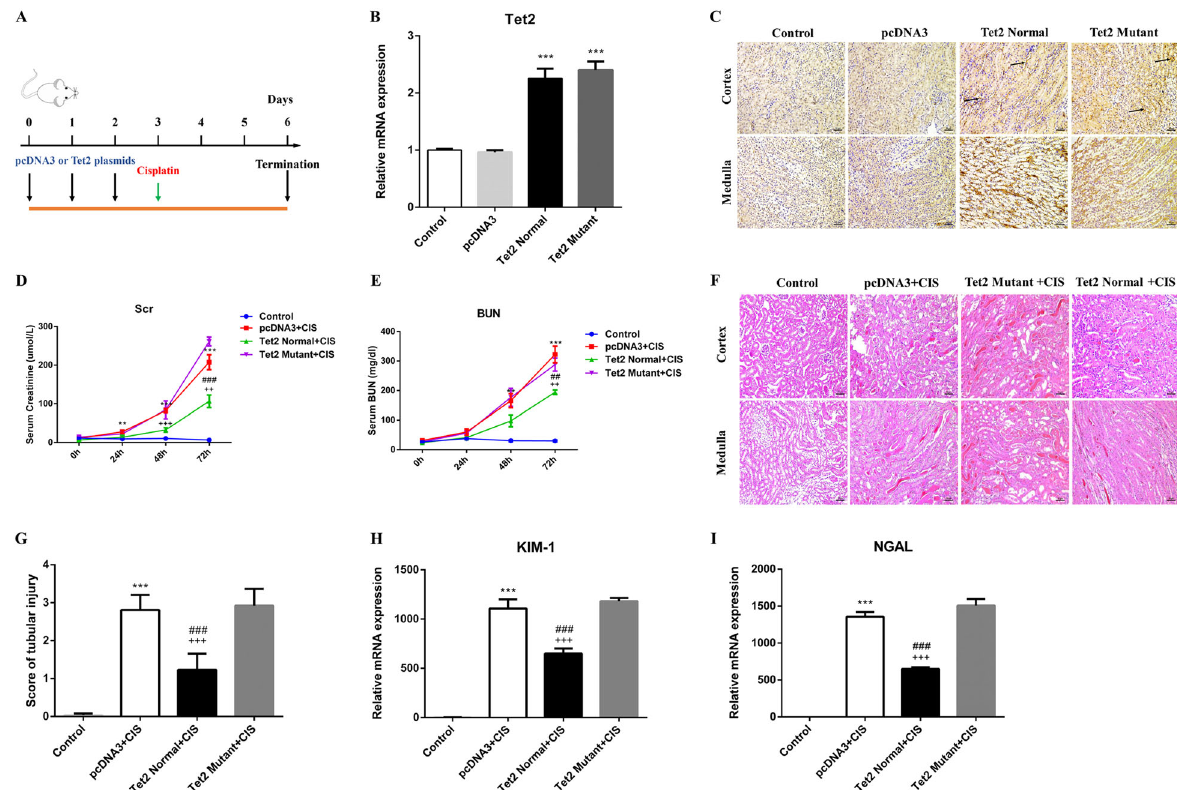
Fig. 4 In vivo expression of Tet2 attenuates cisplatin-induced AKI. A The diagram shows the experimental design. Black arrows indicate the time point of when pcDNA3 or Tet2 plasmids were injected. The green arrowhead represents the time point of cisplatin administration ( n = 3). B , C qRT-PCR analyses and immunohistochemistry of mouse kidney reveal an increased Tet2 expression after plasmids injection. D , E Overexpression of Tet2 Normal plasmid can signi fi cantly reduce the marked elevation of Scr and BUN caused by cisplatin injection. F , G Representative images of HE-stained kidney sections ( n = 6) (200×) and histologic damage in the section were scored by the same evaluation method as shown in Fig. 4. H , I Graphic presentation shows the levels of KIM-1 and NGAL in different groups. *** P < 0.001 versus Control; ### P < 0.001 versus pcDNA3 group; +++ P < 0.001 versus Tet2 Mutant